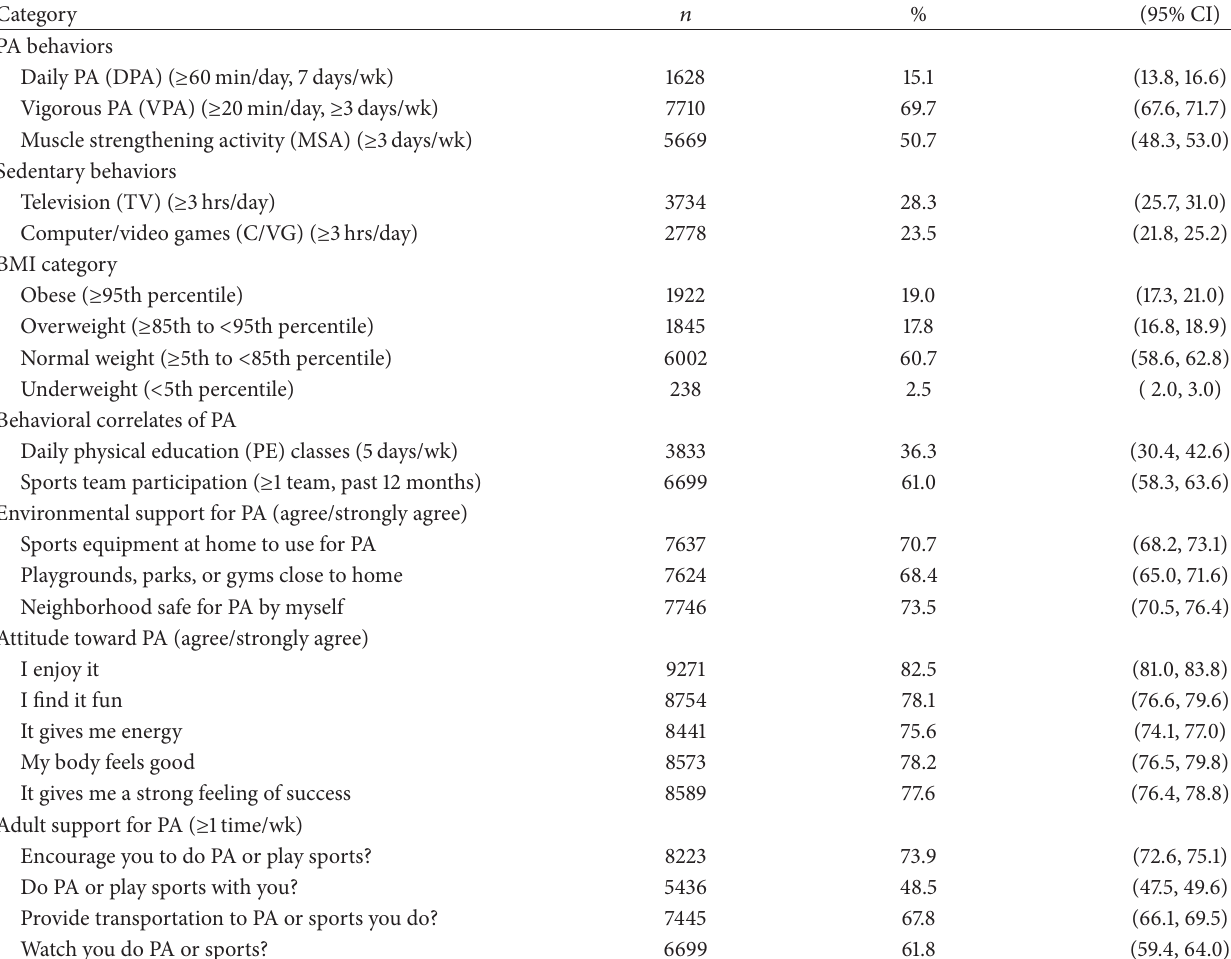
Table2:Unweightedfrequencyandweightedprevalenceofphysicalactivity(PA)andsedentarybehaviors,bodymassindex(BMI)categories, and other PA correlates among US high school